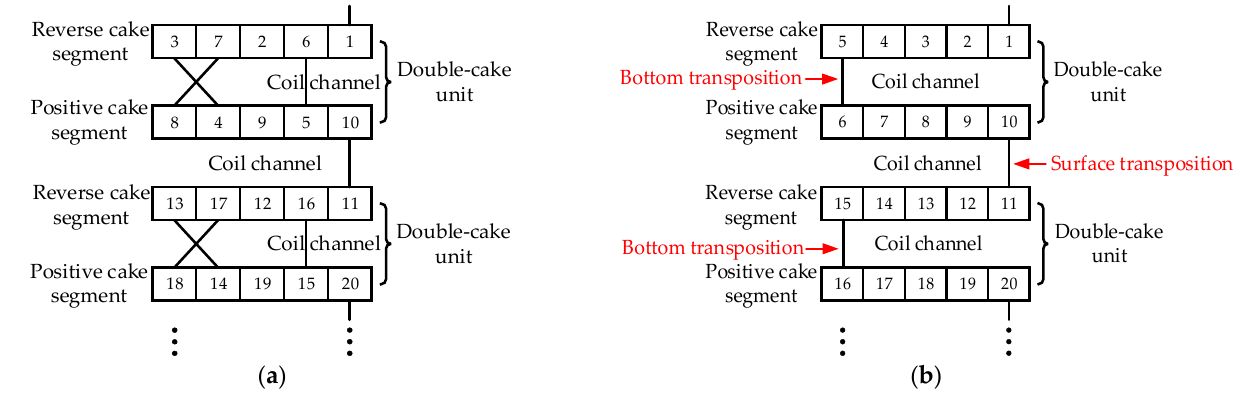
Figure 6. Outspread diagram of primary winding ( a ) Interleaved winding; ( b ) Continuous winding.